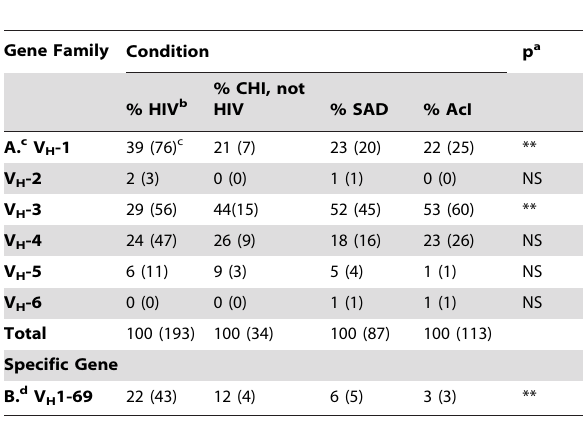
Table 2. Somatic mutations and V H -gene distance of MAbs grouped according to short ( , =13aa), medium (14-18 aa) or long ( . =19aa) CDR-H3 length.